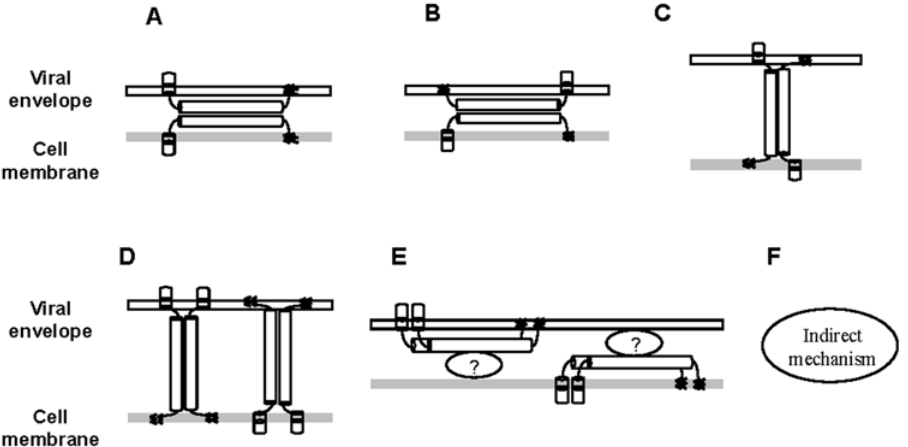
Figure 5. Proposed models for antiviral mechanism of action of tetherin.